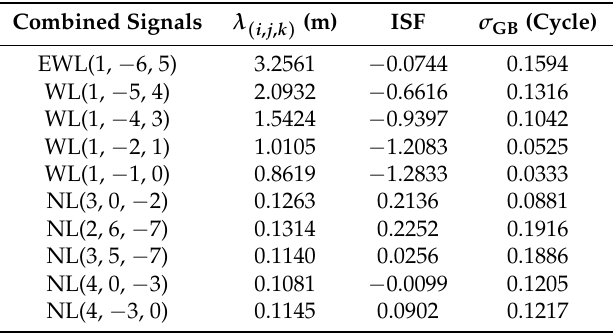
Table 5. Possible combined signals for GB TCAR and their wavelength, ISF and the measurement noise.